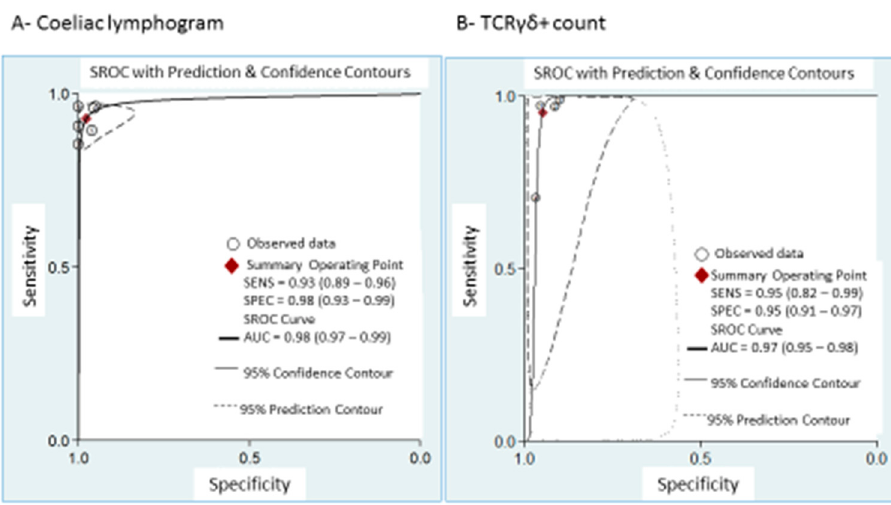
Figure 3. Summary ROC curve (SROC) with confidence and prediction regions around mean operating sensitivity and specificity point of: ( A ) coeliac lymphogram (increase in TCR γδ + IEL plus decrease in CD3 – IEL); ( B ) TCR γδ + count.